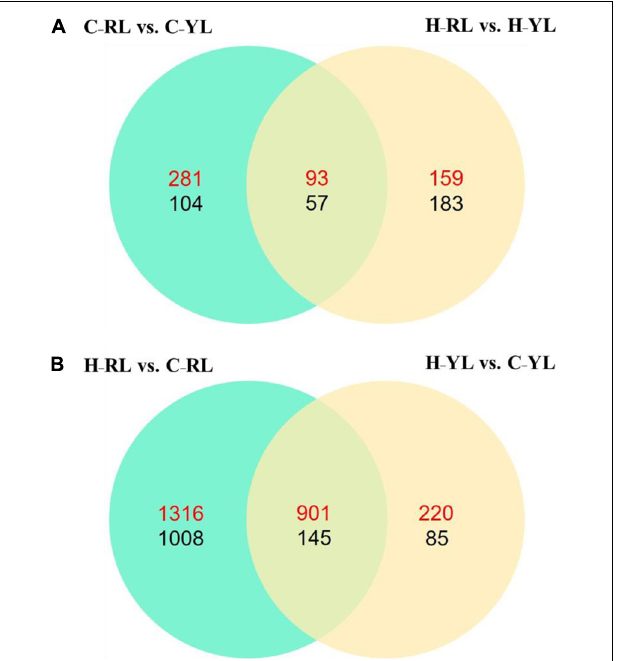
FIGURE 2 | The Venn diagram of significant differently expressed genes. (A) Comparison between different lines. (B) Comparison between control temperature and heat stress temperature. C_RL: RL at control temperature; C_YL: YL at control temperature; H_RL: RL at heat stress temperature; H_YL: YL at heat stress temperature. Up-regulated genes were numbered in red and down-regulated genes were numbered in black.